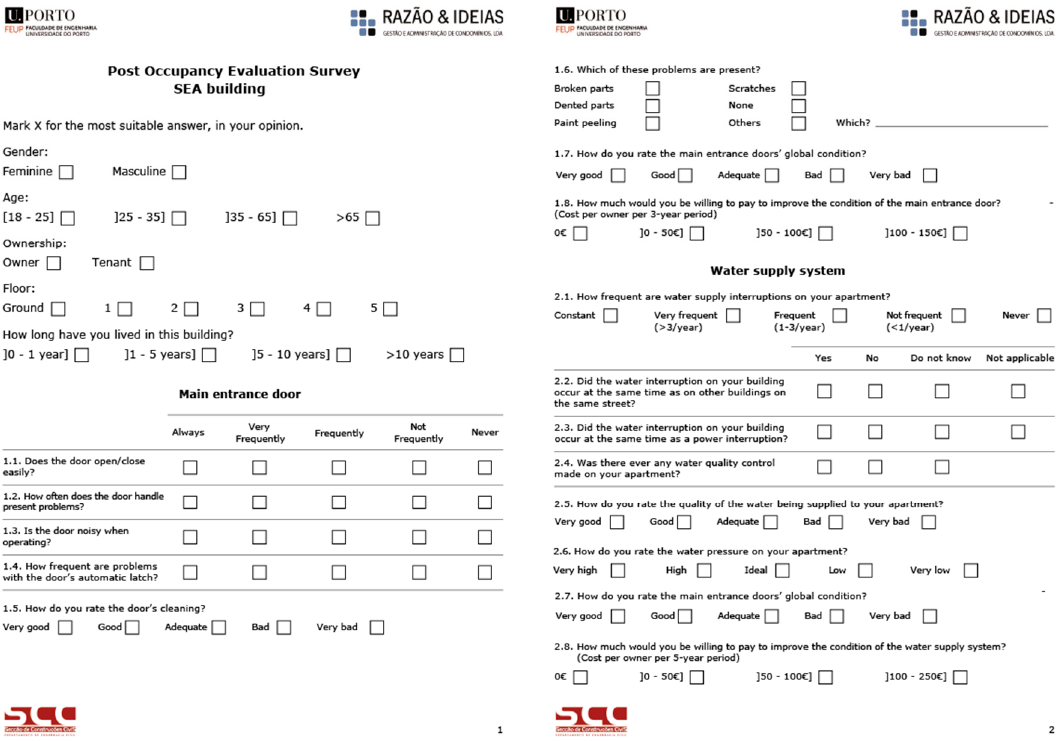
Figure 2. Questionnaire sample. The first questions establish the occupant’s characteristics. The following questions regard the multiple ESMs to be evaluated.